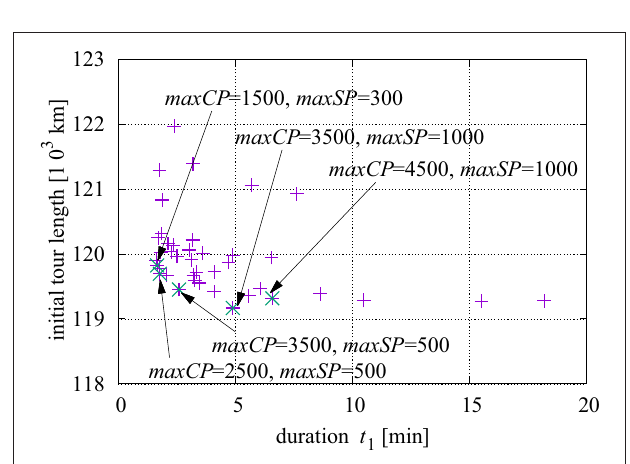
FIGURE 6 | Initial tour length as a function of t 1 and working points with good compromise between length and processing time.